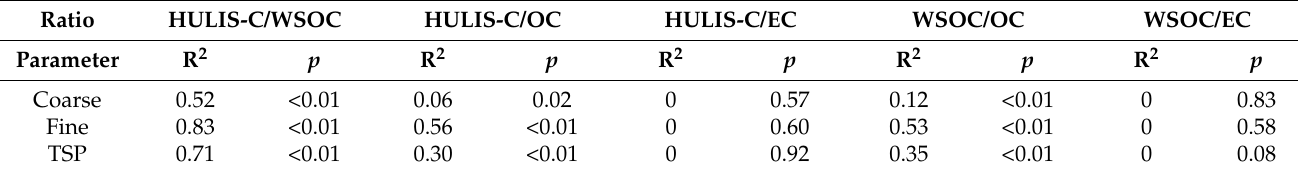
Table 2. Correlation analysis of different types of carbonaceous aerosols in coarse particles, fine particles and TSP. Ratio HULIS-C/WSOC